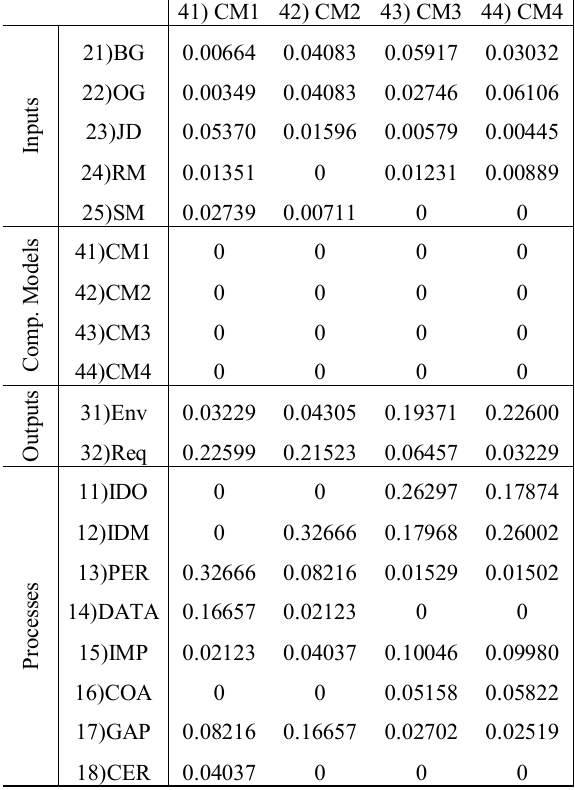
Table 5. A portion of weighted